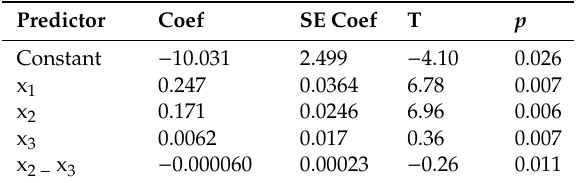
Table 4. Estimated regression coe ffi cient for the desorption of MB.